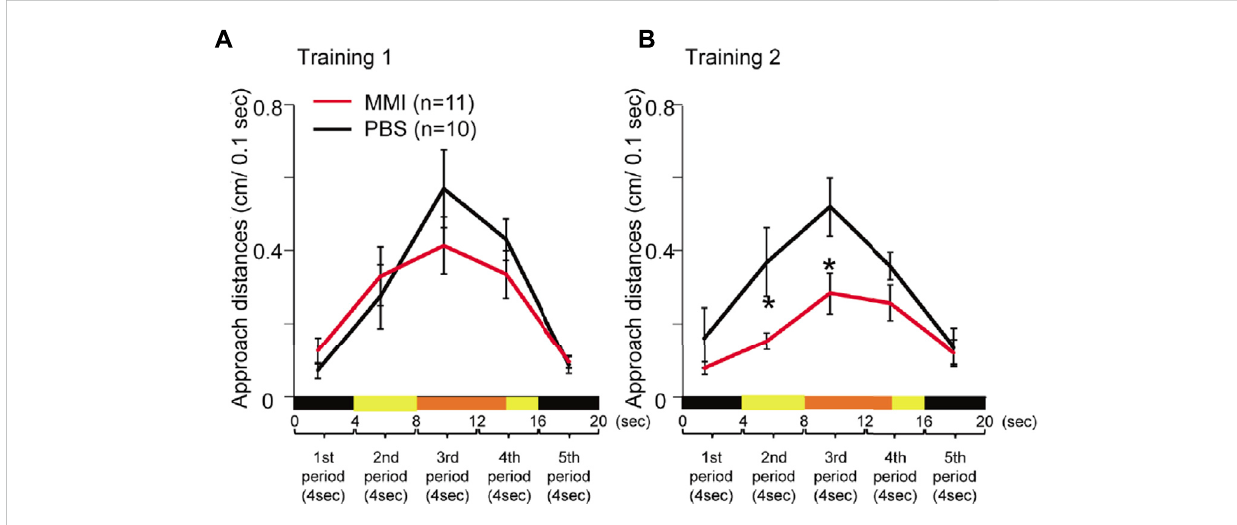
FIGURE 4 The behavior of phosphate-buffered saline (PBS)-administered and methimazole (MMI)-administered chicks during imprinting training. (A) Averaged approach distances during Training one are shown. A trial of 20 s was divided into fi ve periods (4 s each). The black line indicates the approach distances in PBS-administered chicks. The red line indicates the approach distances of MMI-administered chicks. The approach distances of MMI- administered chicks were not signi fi cantly different from those of PBS-administered chicks. (B) During Training 2, the approach distances of MMI- administered chicks in the second and third periods were signi fi cantly shorter than those of PBS-administered chicks. Data represent mean ± SEM. The asterisks (*) indicate signi fi cance ( p <